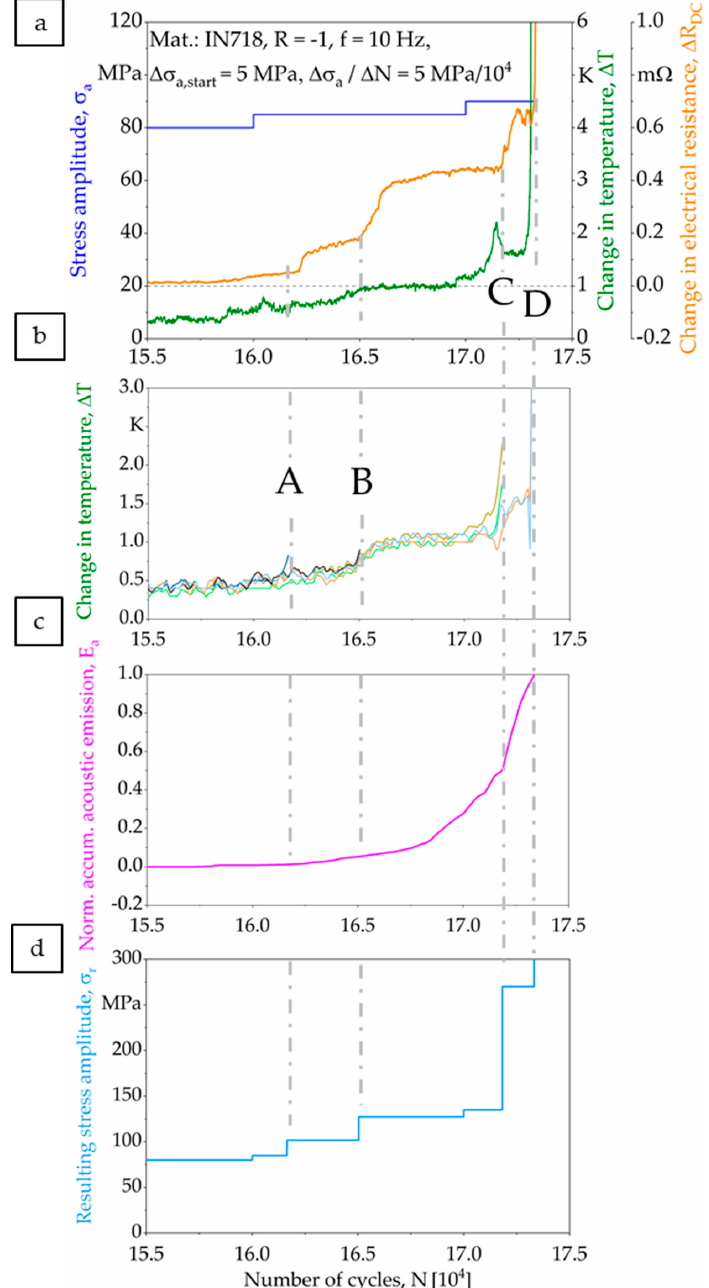
Figure 9. Detailed presentation of material responses that were recorded during the load increase test before failure: ( a ) change in temperature and electrical resistance, ( b ) specific change in temperature for single struts, ( c ) normalized accumulated acoustic emissions, and ( d ) evolution of nominal stress for remaining